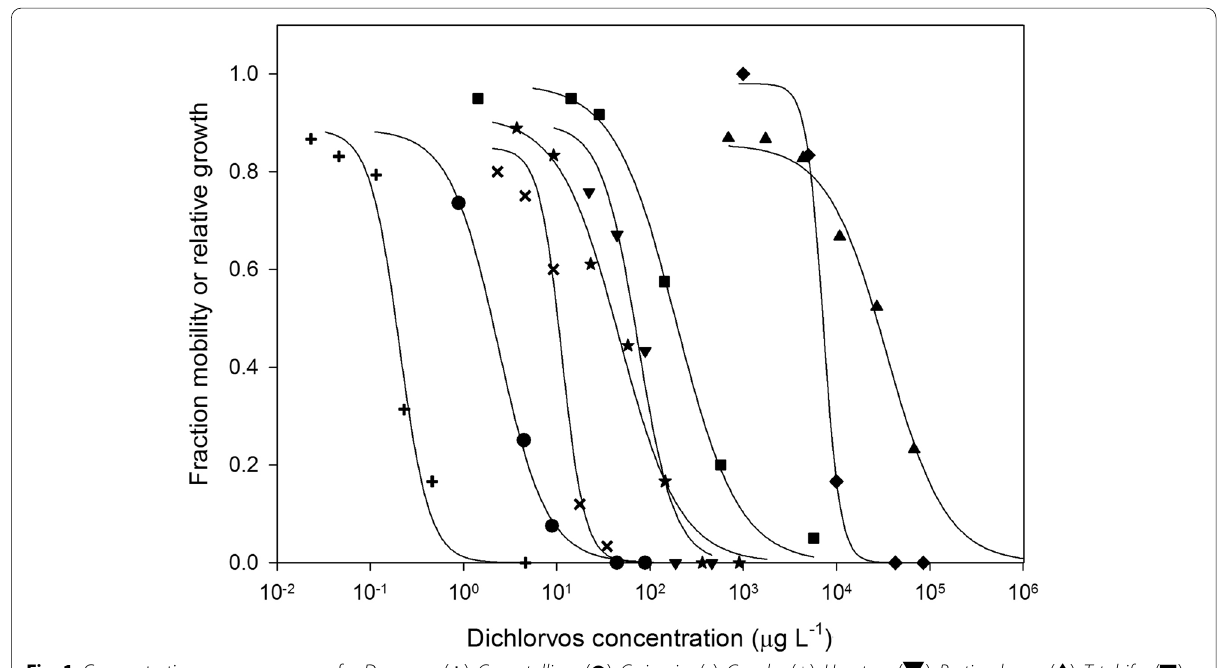
Fig. 1 Concentration-response curves for D. magna ( ), C. crystallinus ( ● ), C. riparius (x), G. pulex ( ⋆ ), H. azteca ( ▼ ), P. atipodarum ( ♦ ), T. tubifex ( ■ ) + after 48 h of exposure. Concentration-response curve for L. minor after 7 d of exposure ( ▲ ). Control mortality was < 20% for all species and control growth rates of L. minor was > 0.3 d −